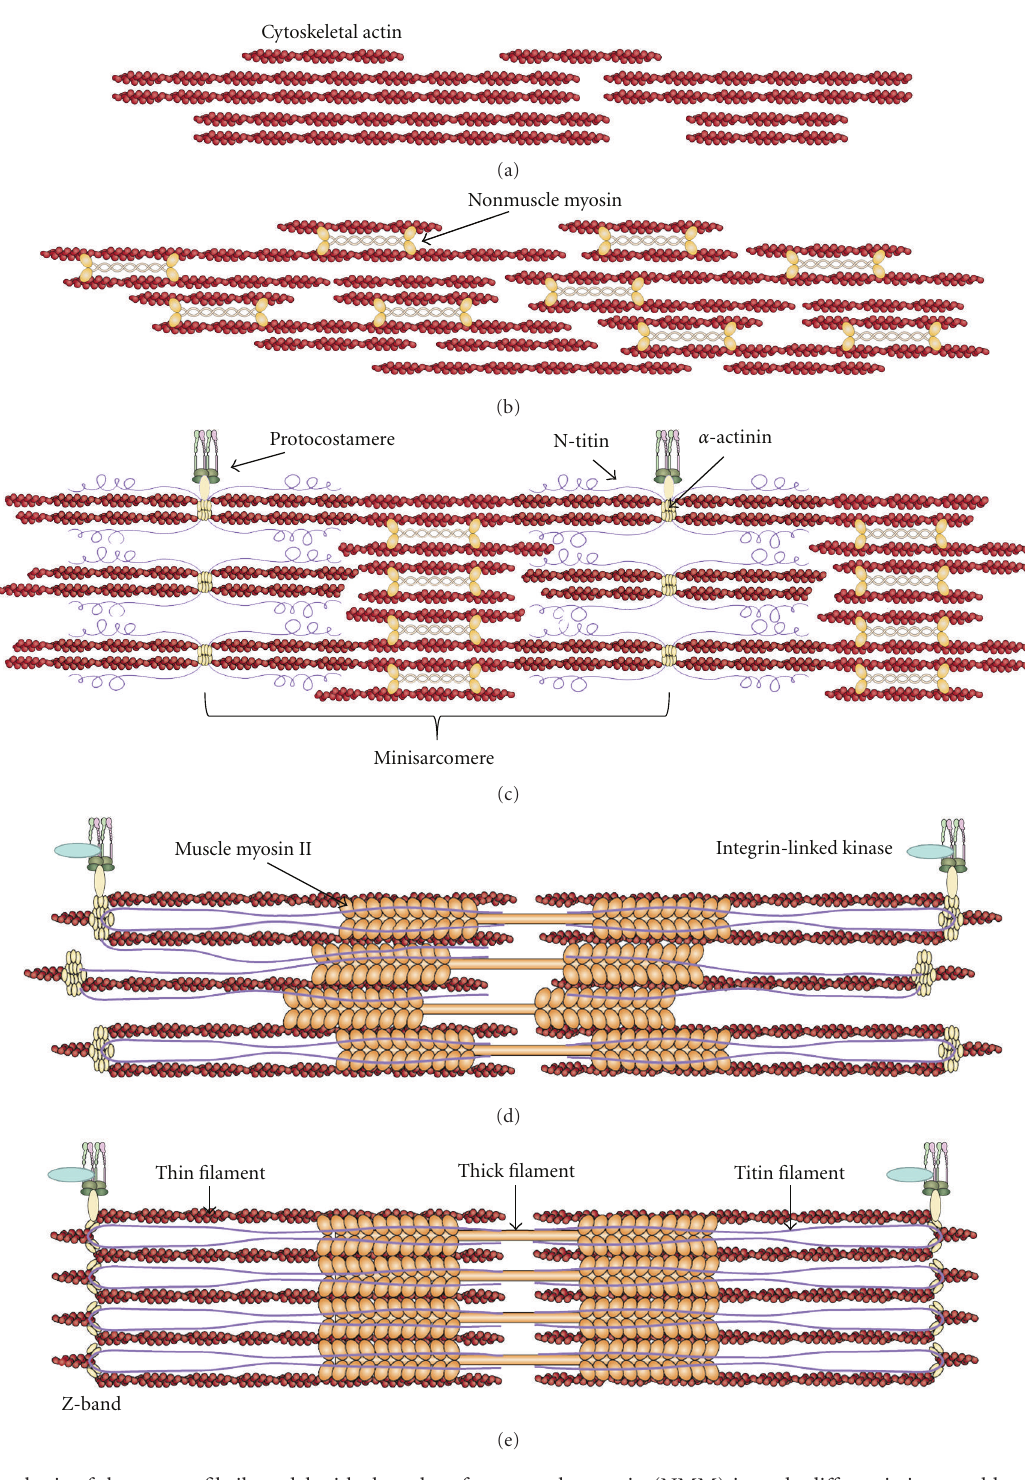
Figure 3: Synthesis of the premyofibril model with the roles of nonmuscle myosin (NMM) in early di ff erentiating myoblasts. Schematic representation of the molecular events leading from cytoskeletal actin to mature myofibrils. (a) Elaboration of the actin cytoskeleton in proliferating myoblasts leads to the formation of a cortical actin wall. (b) Stress-fiber-like structures in the cortical actin wall contain associated NMM-II, which allows for alignment and fusion of myoblasts. (c) Alignment and fusion are concurrent with early costamere formation, resulting in the anchorage of premyofibrils to the extracellular matrix. These sites serve as nucleation points, resulting in the formation of minisarcomeres with alternating bands of α -actinin and NMM. Incorporation of N-terminal titin occurs at this point as well. (d) Folding and lengthening of titin is concurrent with the organization of α -actinin into the Z-band and the incorporation of muscle MHC-II into the thick filament, displacing NMM and widening sarcomeres. (e) M-line proteins associate with MHC-II and C-terminal titin, creating the final banding pattern of mature myofibrils. Modified from Sparrow and Schock